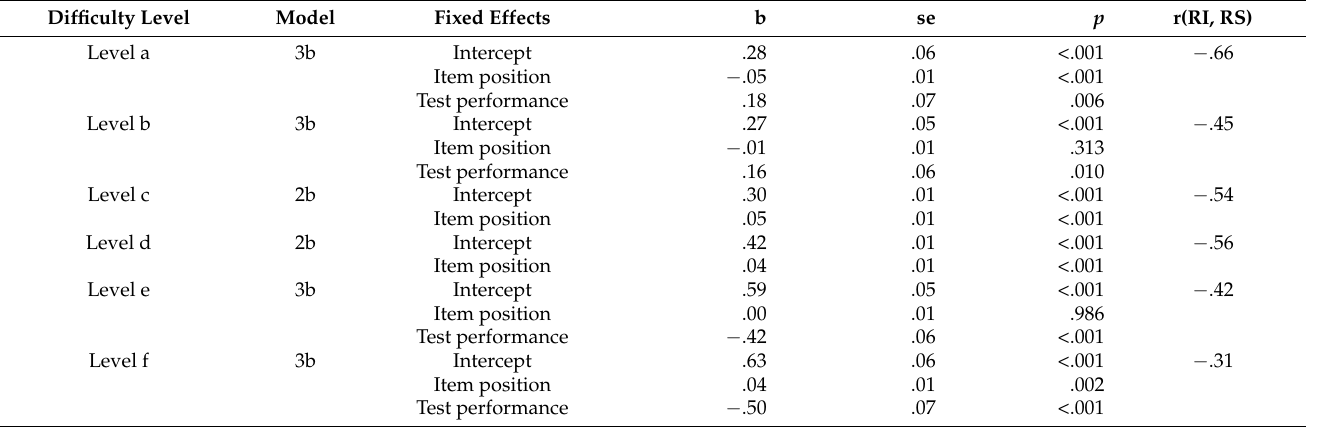
Table 7. Fixed effects and correlations between random intercept (RI) and random slope (RS) of the MLM with the dependent variable